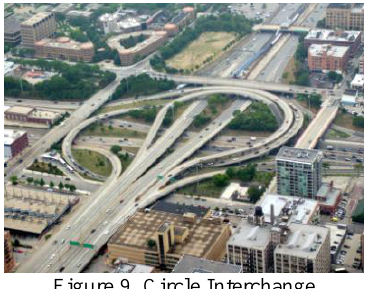
Figure 9. Circle